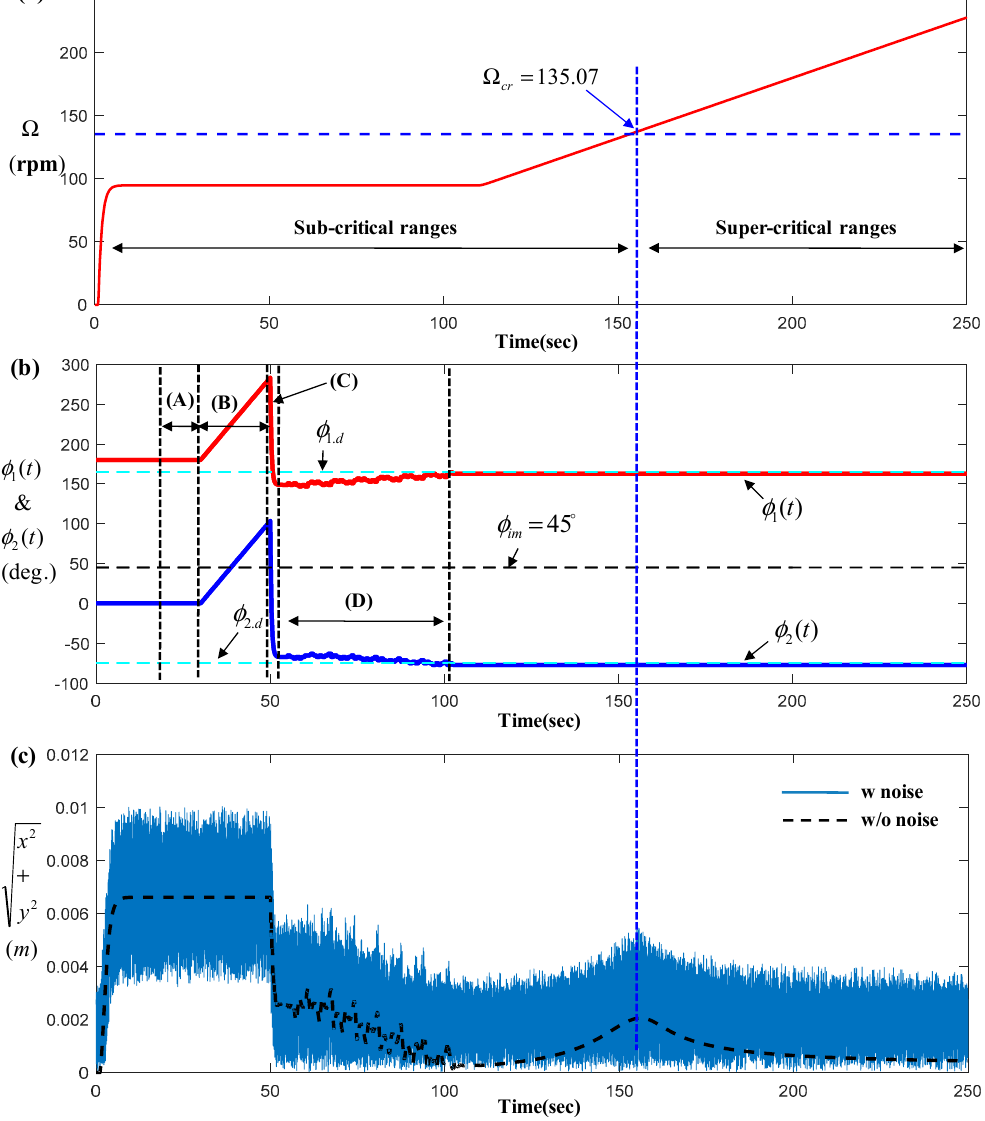
Figure 9. AAEMS control for a particular scenario (( a ) rotor’s rotational speed, ( b ) the angular position of AAEMS and ( c ) the vibration amplitude of rotor.).